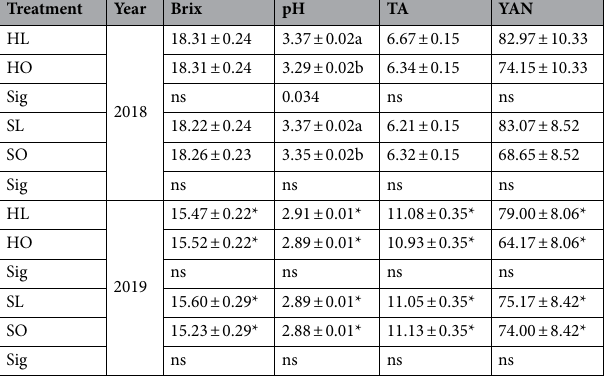
Table 5. Effect of lateral removal on the fruit composition of ‘Riesling’. Significant differences between treatments ( p < 0.05) are designated by different letters. Significant differences between years ( p < 0.05) are designated by